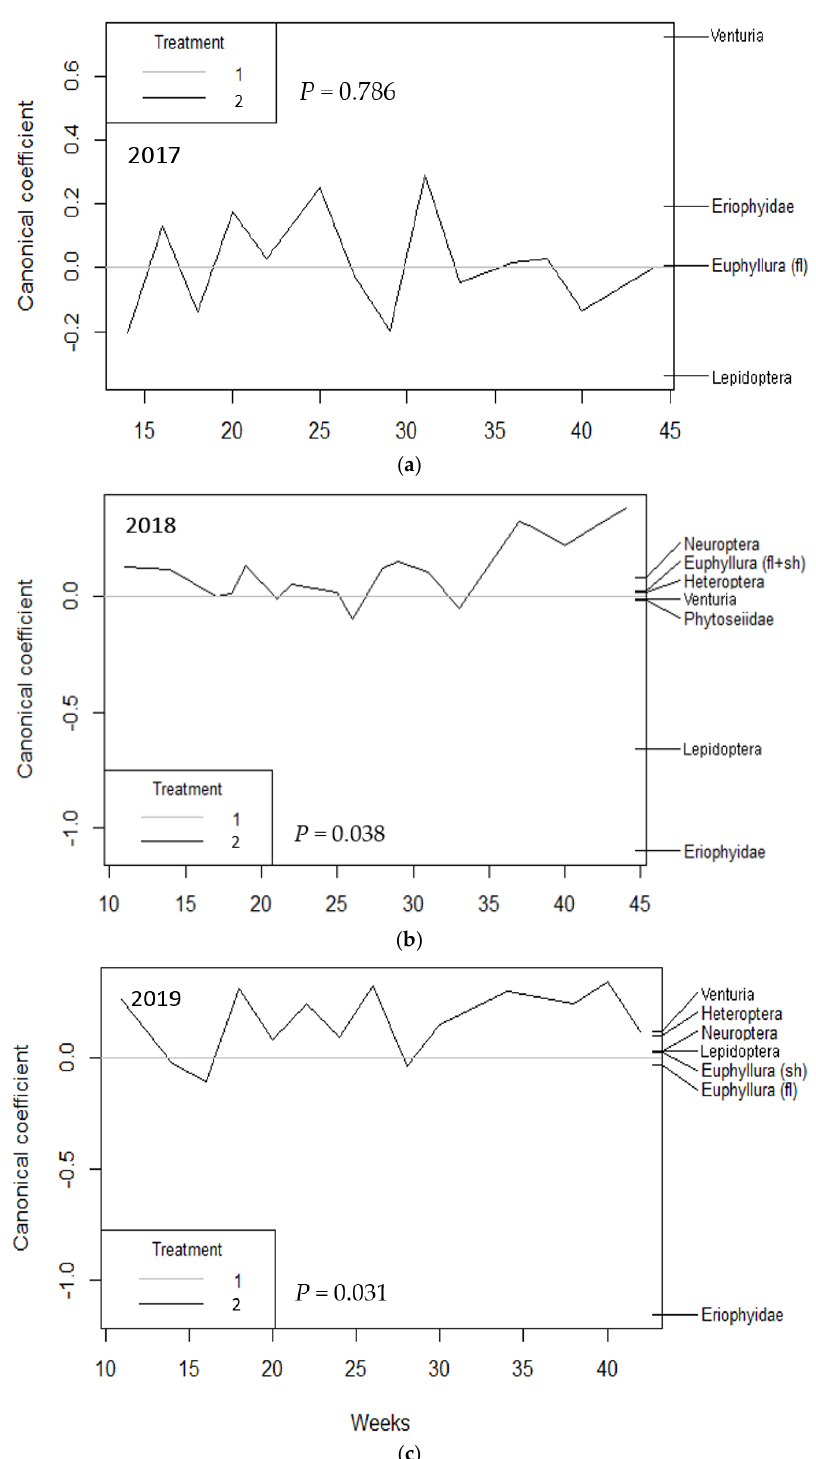
Figure 3. Principal response curves (PRC) of the most important arthropod taxa and disease registered in the visual sampling for ( a ) 2017, ( b ) 2018, and ( c ) 2019. The P values denote the significance of treatment T2 (Confederation RDI), represented as a plotted line, relative to treatment T1 (control) over all dates based on an F-type permutation test. Observation groups are shown on the right vertical axis with their weights, which have the same scale as the canonical coefficients on the left vertical axis; ‘fl’ and ‘sh’ means ‘flowers’ and ‘shoots’, respectively.